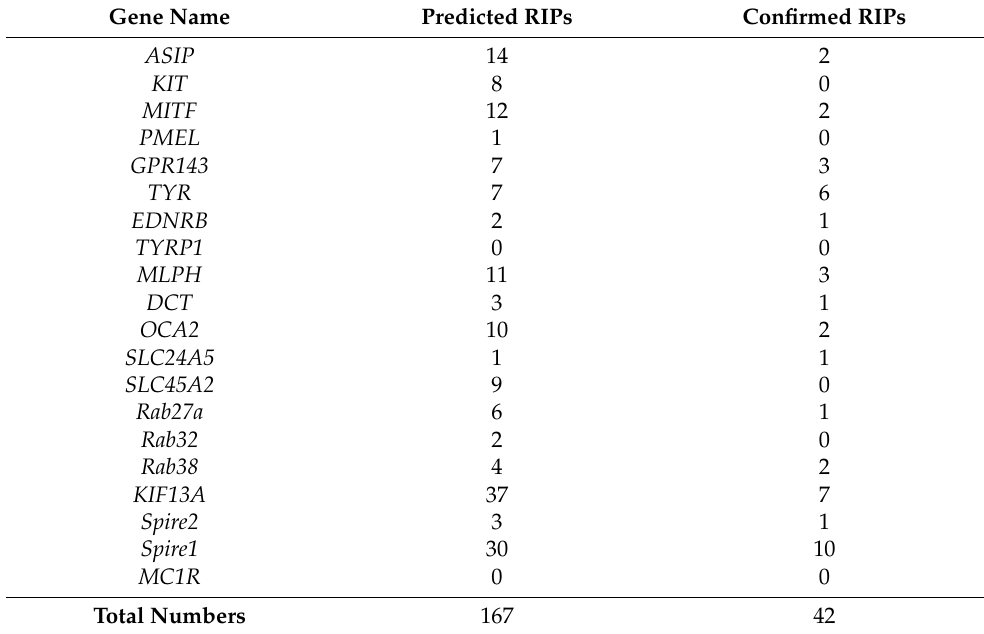
Table 1. Predicted large structural variations (SVs) by alignment in coat-color genes and their flanking